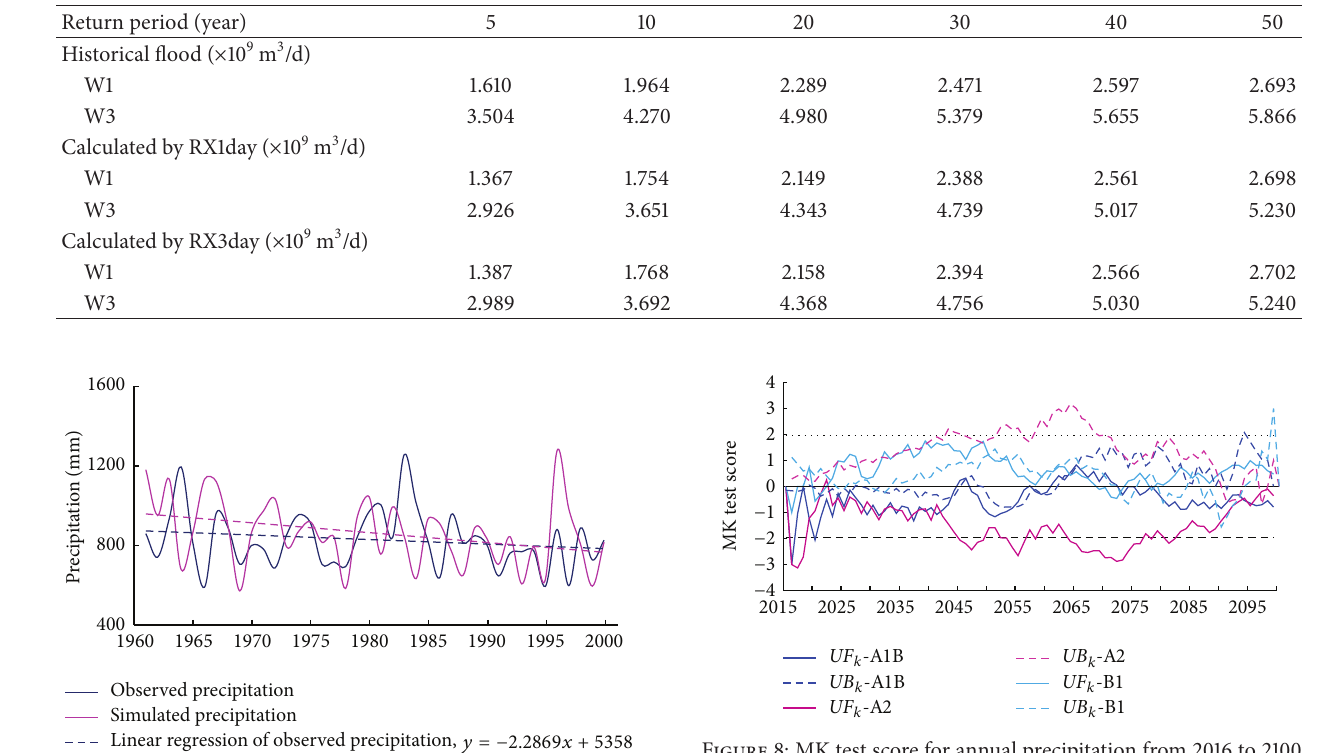
Table 8: Future and historical predicted extreme flood discharges for a range of return periods.